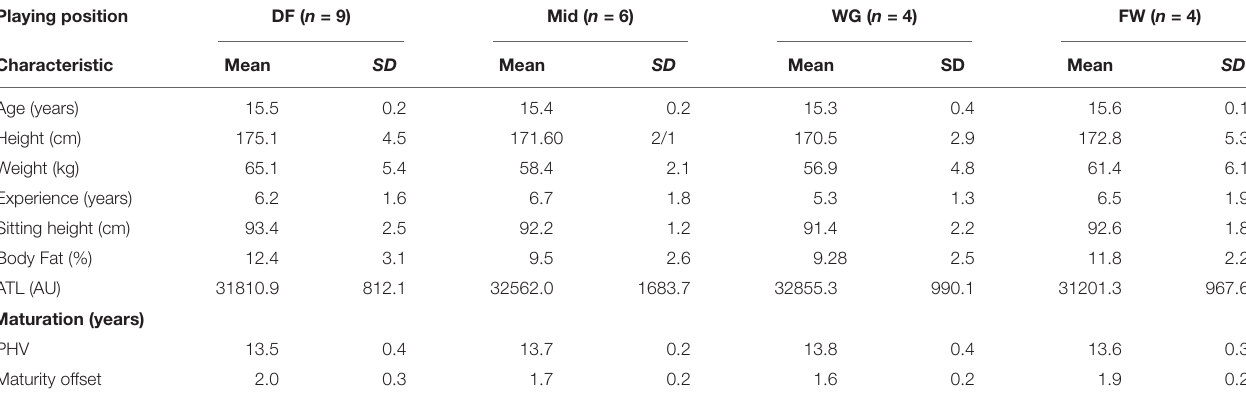
TABLE 2 | Descriptive characteristics of U16 soccer players ( n = 23) by playing positions. Playing position